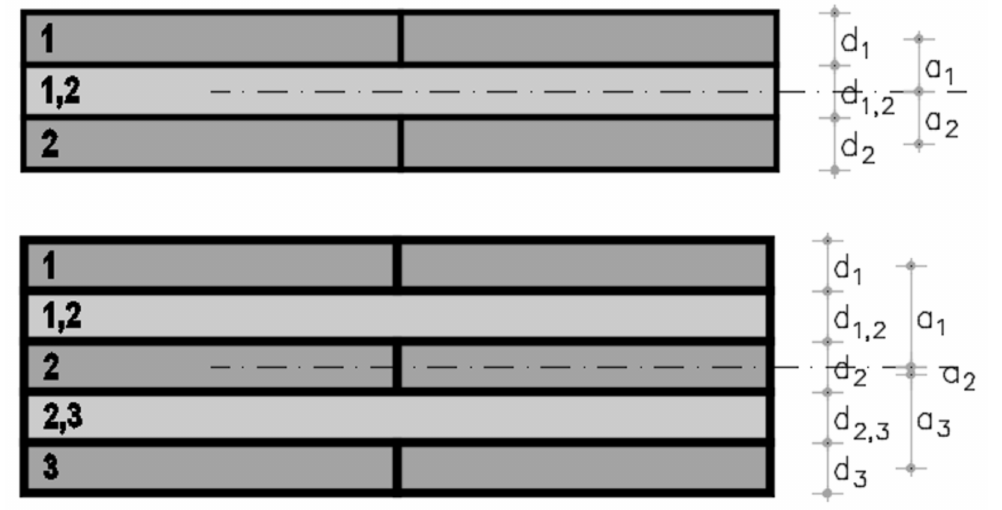
Figure 4. Layout of the 3- and 5-layer CLT according to the Gamma